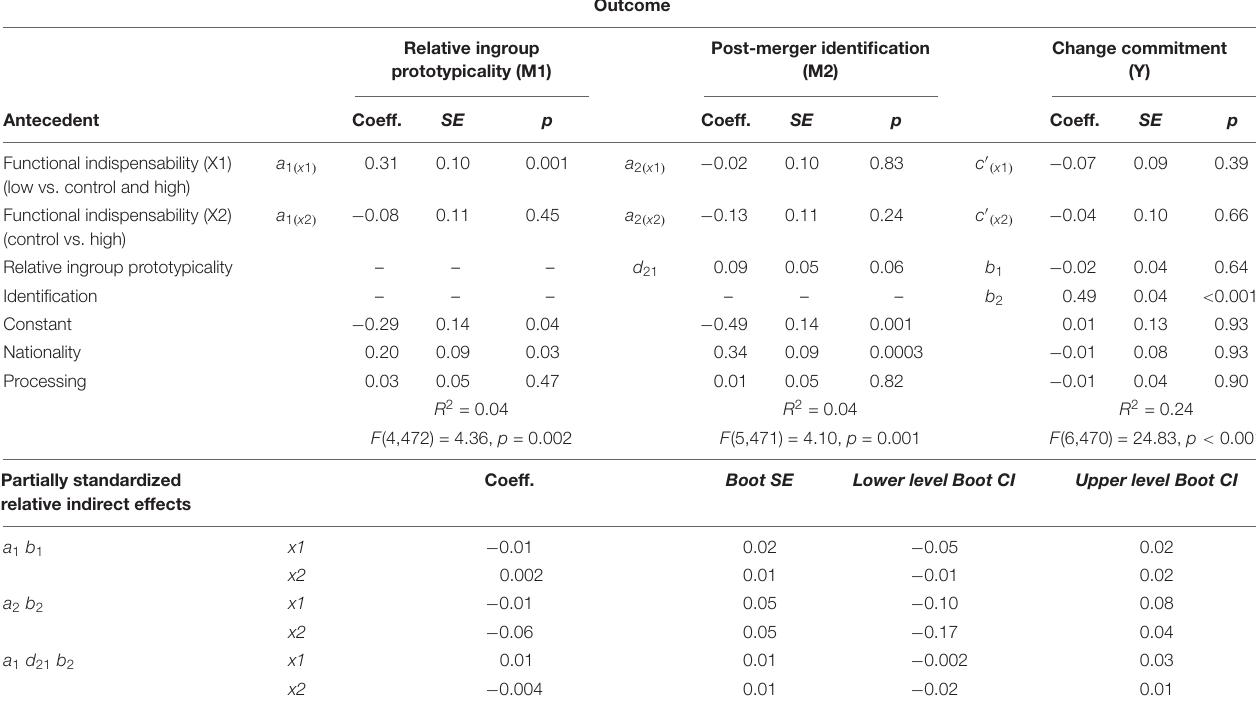
TABLE 2 | Summary of sequential mediation, Study 1 ( Figure 1 for